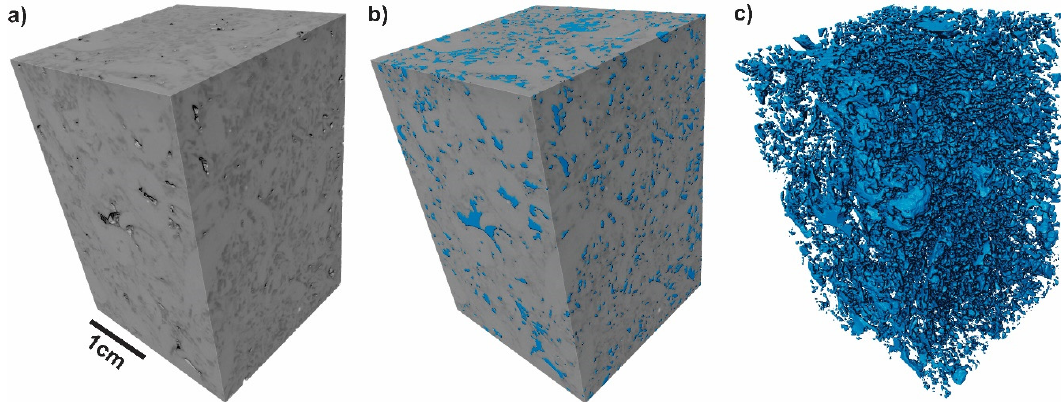
Figure 3. The volume of interest used in the digital sample. ( a ) microCT images of the coquina, and ( b ) rock matrix in grey and segmented pores in blue. ( c ) Segmented pore system.